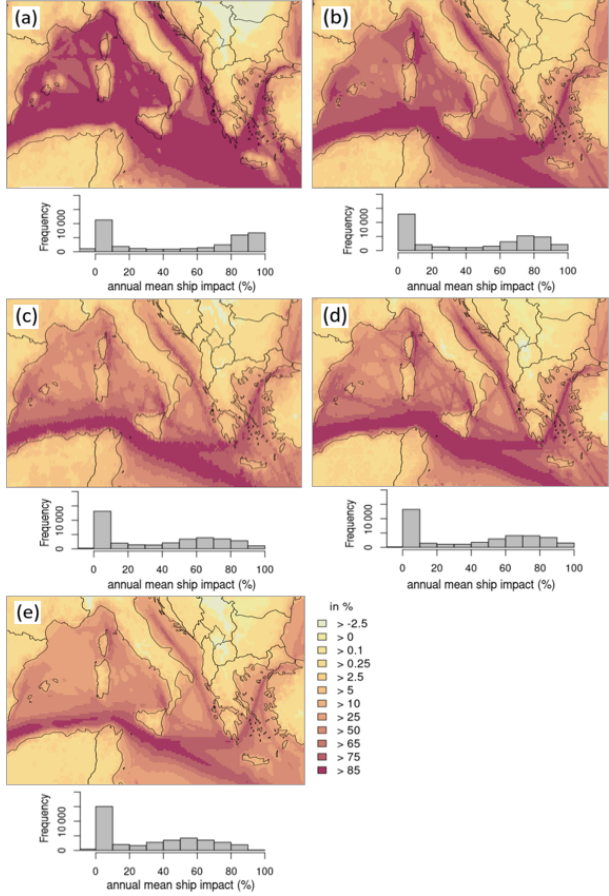
Figure E1. Annual mean of NO x total concentration. (a) CAMx; (b) CHIMERE; (c) CMAQ; (d) LOTOS-EUROS. Below the do- main figure the respective frequency distribution is displayed for the annual mean NO x concentration, referring to the whole model domain.